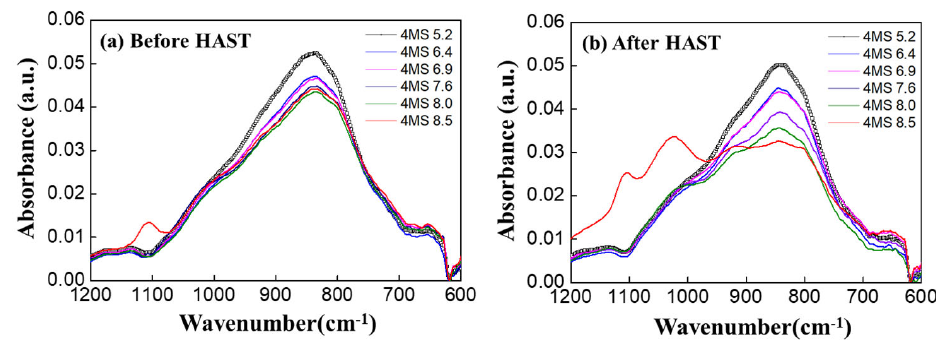
Figure 12. FT ‐ IR analysis results ( a ) before and ( b ) after the HAST according to the 4MS PPR.